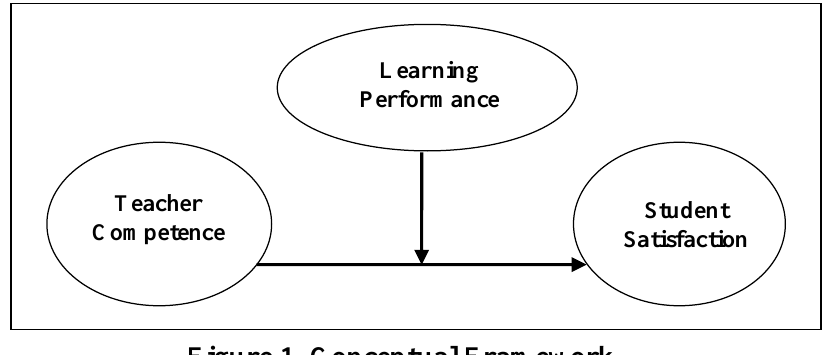
Figure.1. Conceptual